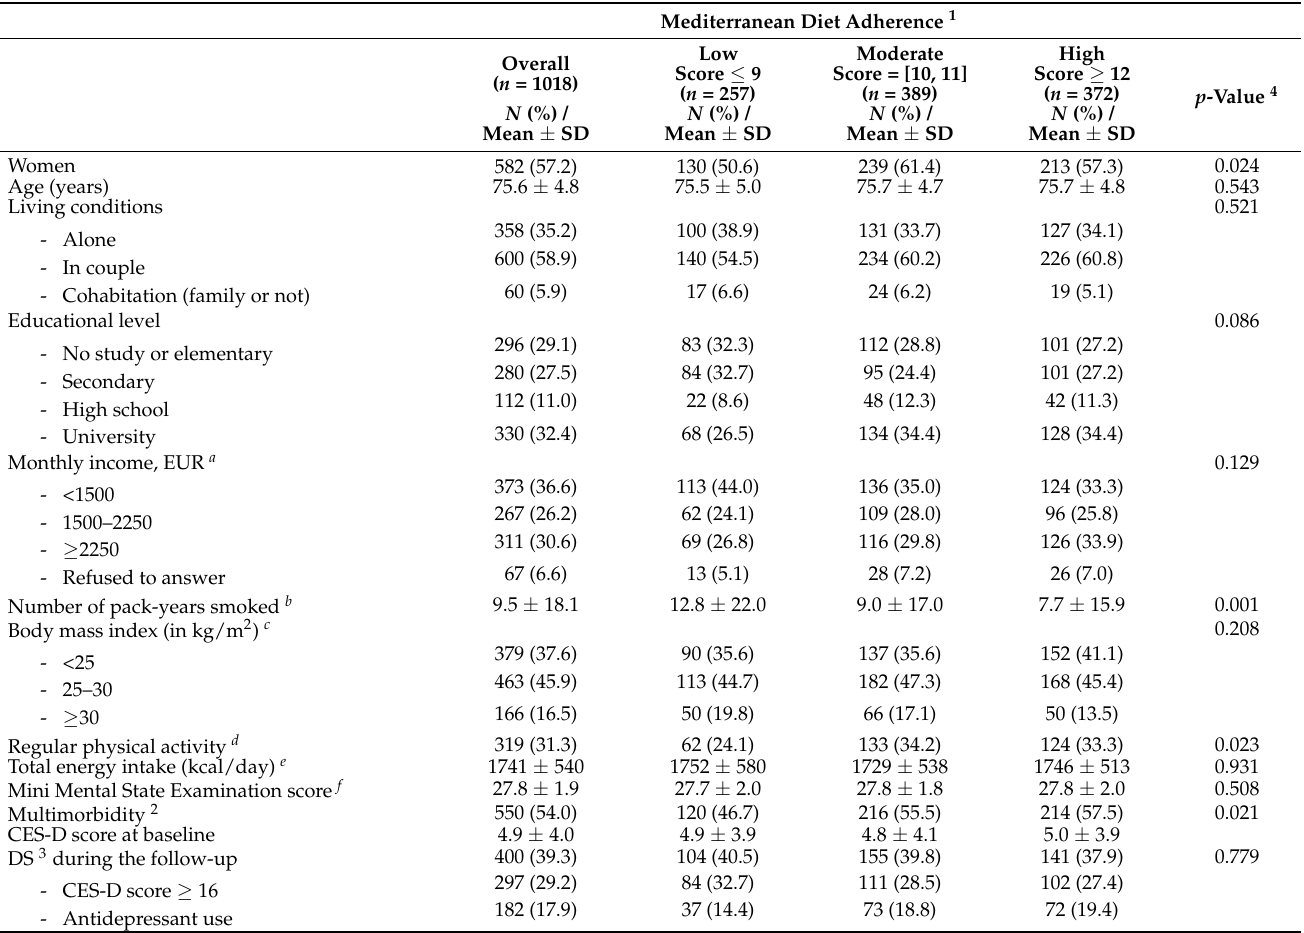
Table 1. Description of sociodemographic and lifestyle characteristics of the study sample according to adherence to the Mediterranean diet from the MeDi-Lite score, from the Three-City Bordeaux cohort, 2001–2017. ( N =